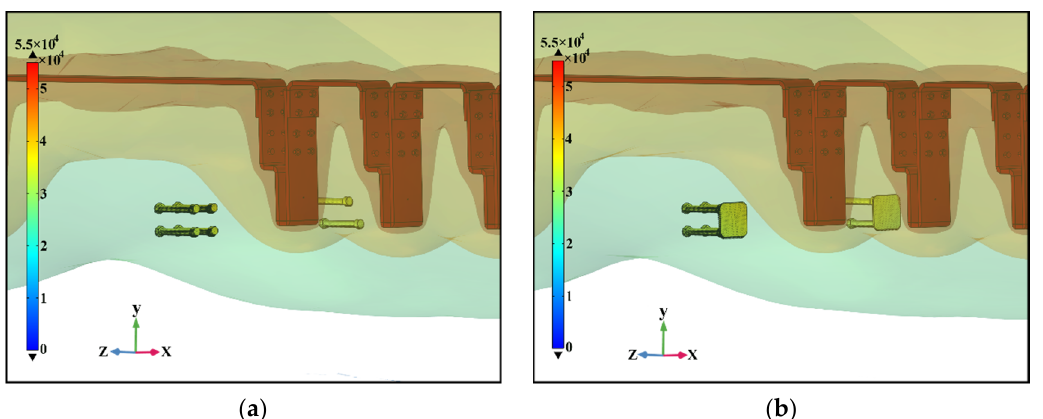
Figure 15. Shortening of metal bolts.